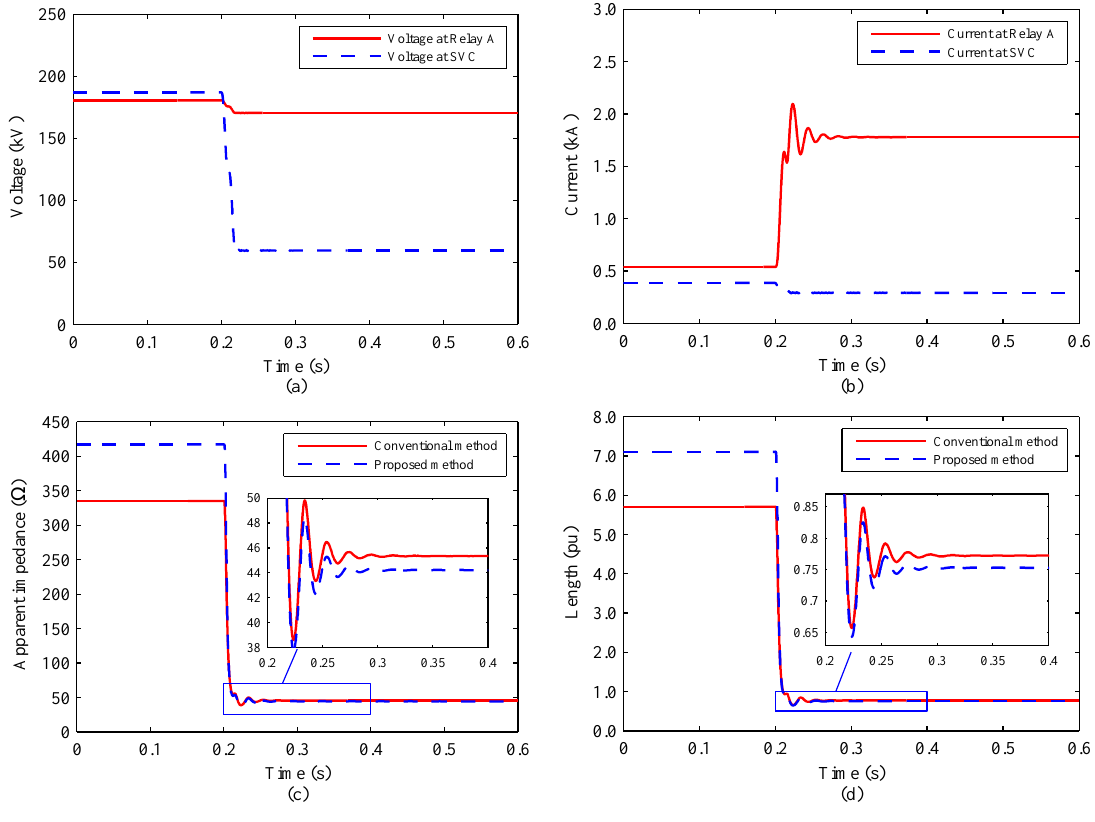
Figure 7. The simulation results of Case 2. ( a ) voltage measurement; ( b ) current measurement; ( c ) apparent impedance at relay A; ( d ) fault